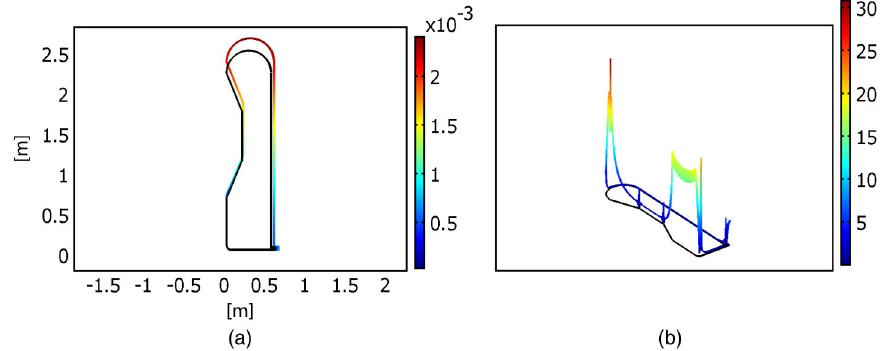
FIG. 20. Displacement field (in m) (a) and von Mises stress (in MPa) (b) due to thermal dilatation with uniform temperature 60 °C. T horn ¼